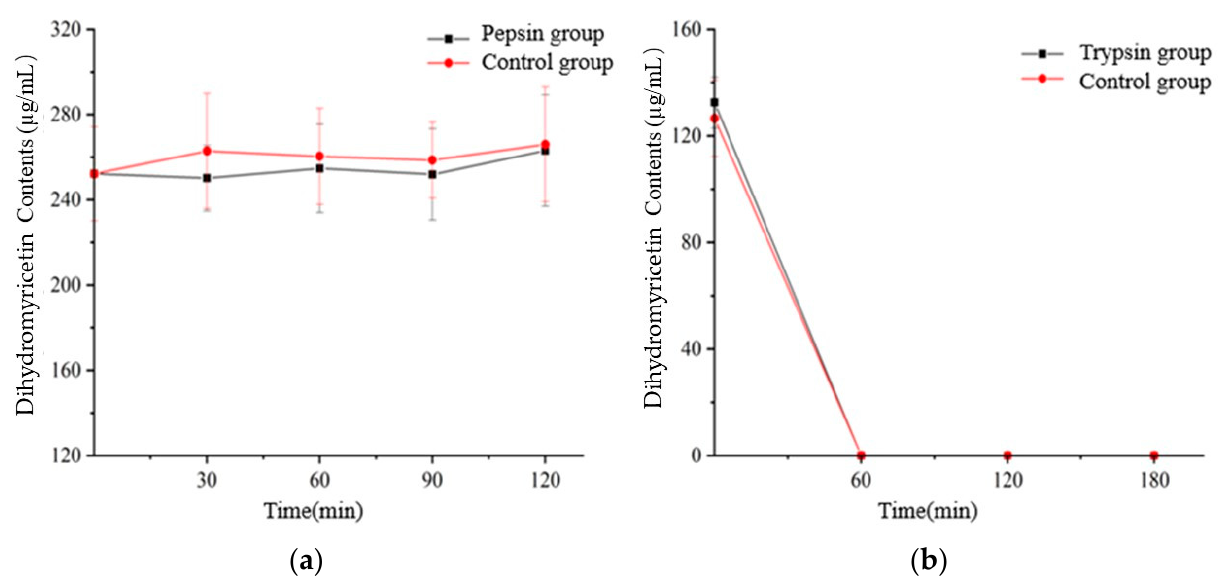
Figure 7. Changes of dihydromyricetin standard content of the extract digested before and during gastric phase ( a ) and intestinal phases ( b